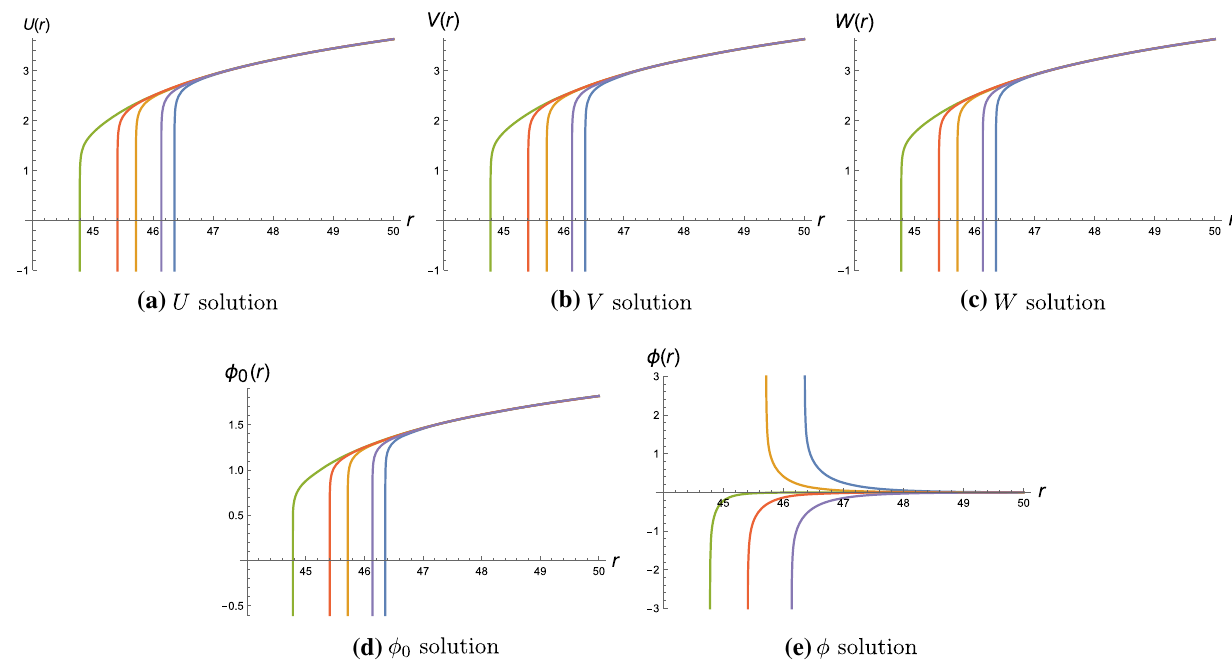
Fig. 42 Supersymmetric flows interpolating between asymptotically locally flat domain walls and Mk w 2 × H 2 × R 2 -sliced curved domain walls in SO ( 4 ) gauge group. The blue, orange, green, red and purple curves refer to − 0 . 5 , − 0 . 12 , − 0 . 03 , 0 , 0 . 25, respectively